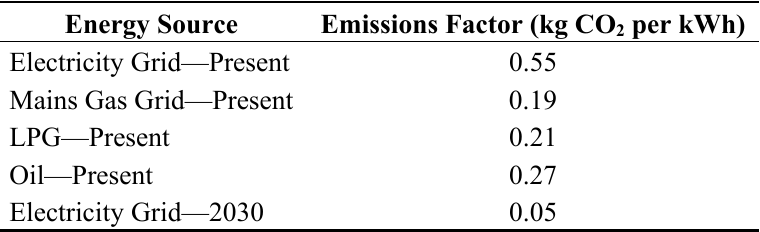
Table 2. Energy source emissions